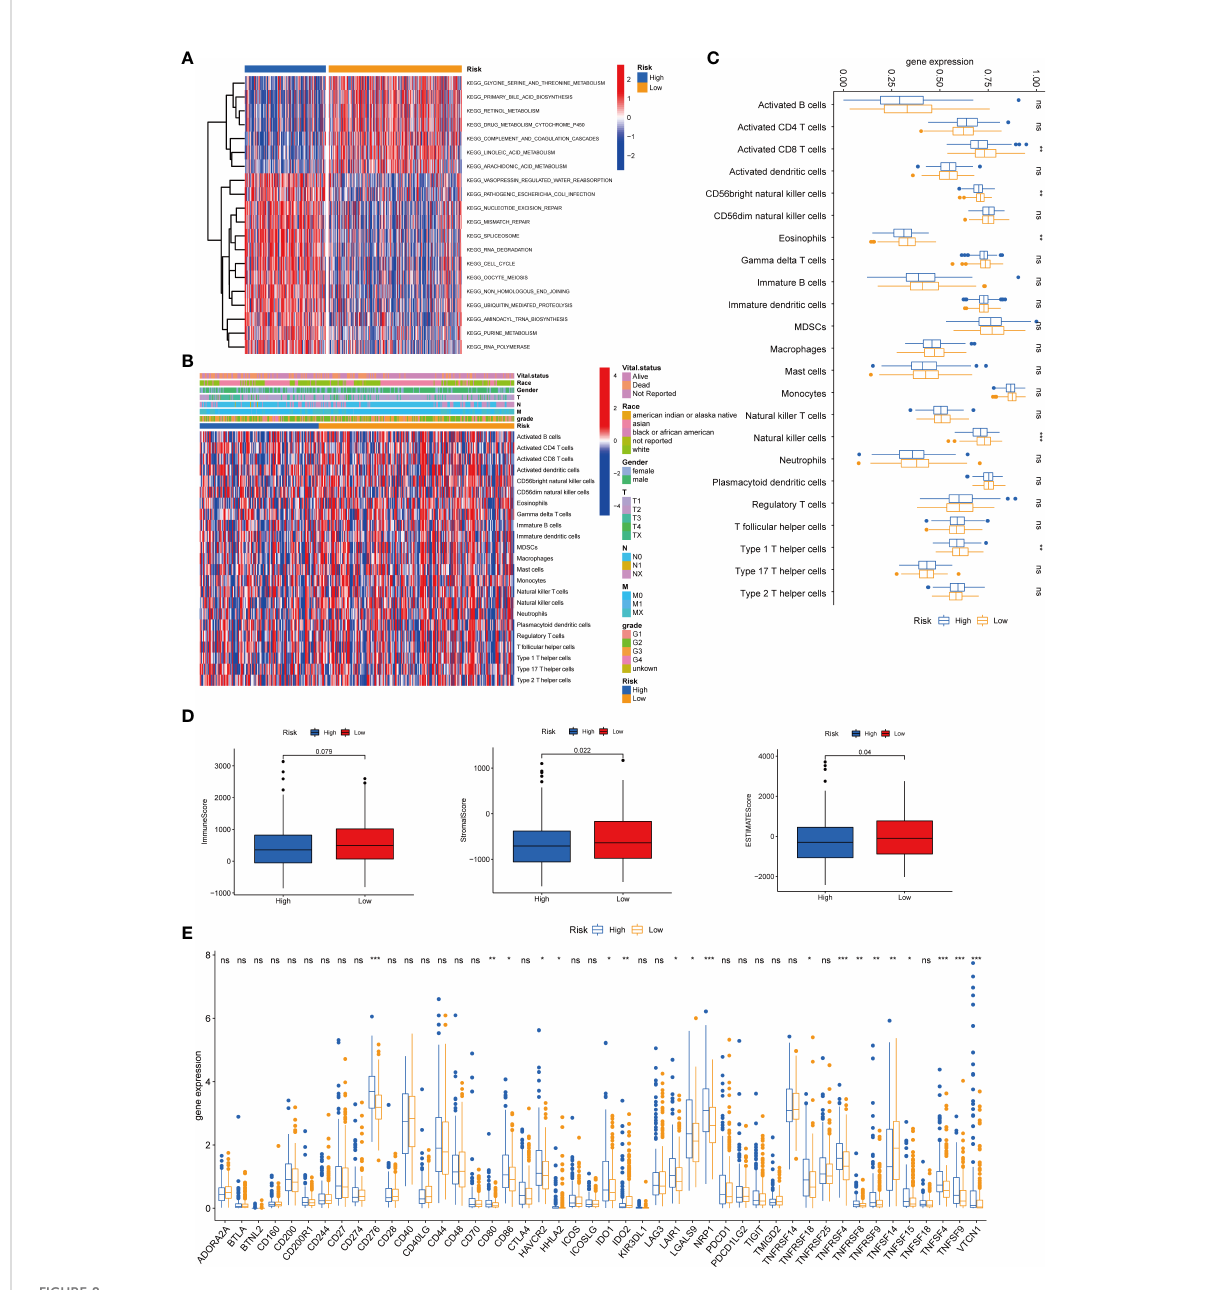
FIGURE 8 Correlations of tumor immune cell microenvironments and two TRGs prognostic subtypes. (A) GSVA of biological pathways between two risk groups, in which red represent activated and blue inhibited pathways, respectively. (B) Heatmap of the clinicopathologic characteristics and tumor-in fi ltrating cells in the two risk groups. (C) Expression abundance of 23 in fi ltrating immune cell types in the two risk subtypes. (D) Correlations between the TME score and the two risk subtypes. (E) Expression of immune checkpoints between the two risk subtypes. *p < 0.05, **p < 0.01, ***p < 0.001, ns, no signi fi cant difference. TRGs, tyrosine metabolism-related genes; GSVA, gene set variation analysis; TME, tumor